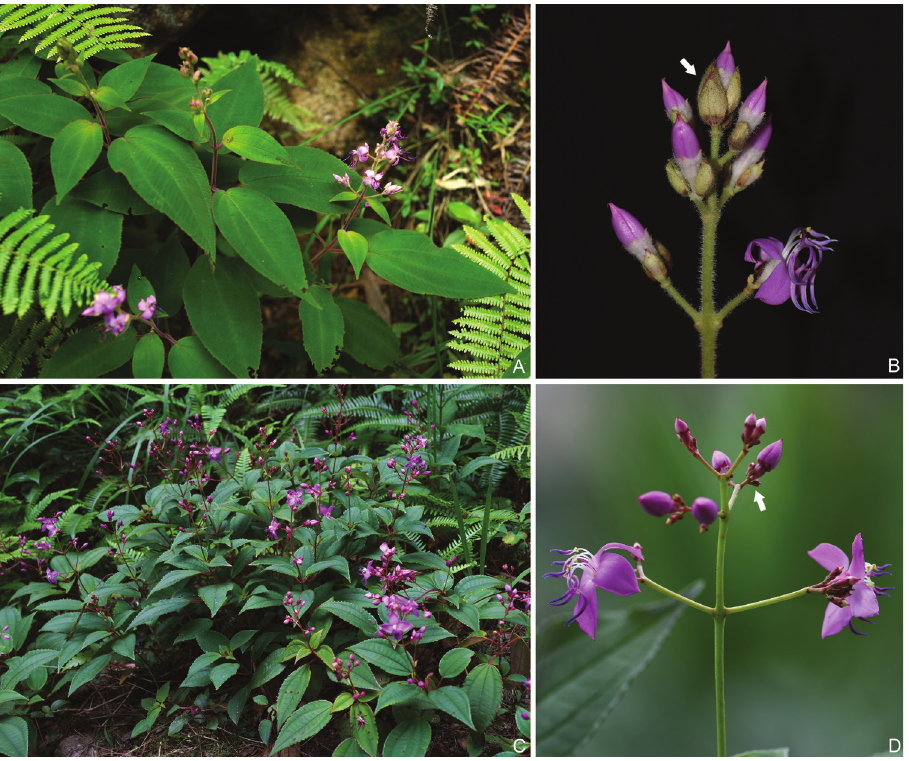
Figure 12. Tashiroea villosa ( A–B ) and T. amoena ( C–D ). A Habit B Inflorescence showing large bracts C Habit D Inflorescence showing minute bracts. Photographed by Xiang-xiu Su ( A, C ) and Ying Liu ( B, D